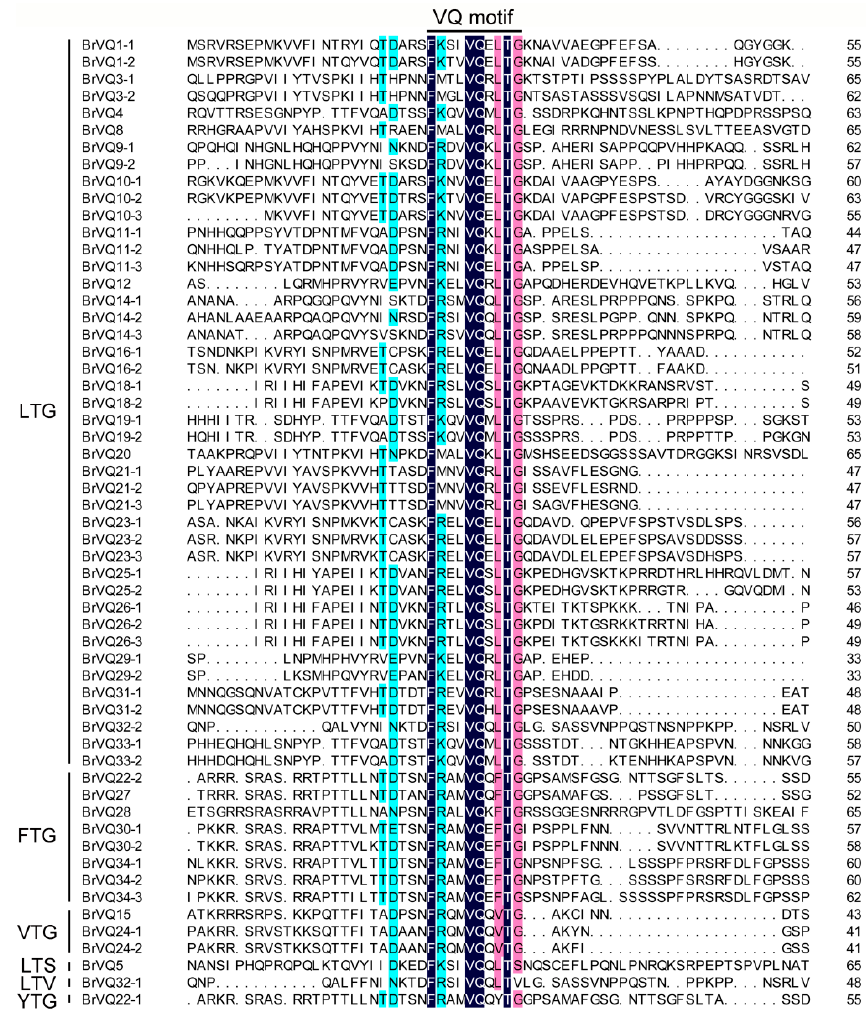
Figure 4. Multiple sequence alignment of the VQ proteins in Chinese cabbage. The sequences were aligned using the DNAMAN software. The highly conserved motif is FxxxVQxLTG.